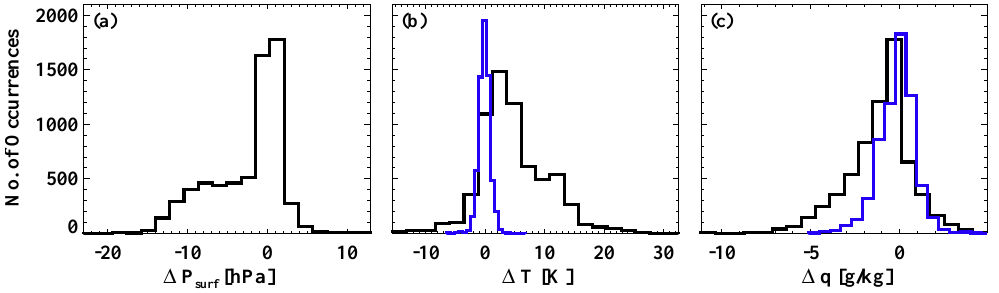
Fig. 10. Differences between select NCEP and ECMWF meteorological variables; both have been spatially and temporally interpolated to the target locations and times with similar interpolation schemes. All differences are NCEP minus ECMWF. (a) Surface pressure difference. (b) Air temperature difference at the surface (black) and at 700hPa (blue). (c) Specific humidity difference at the surface (black) and at 700hPa